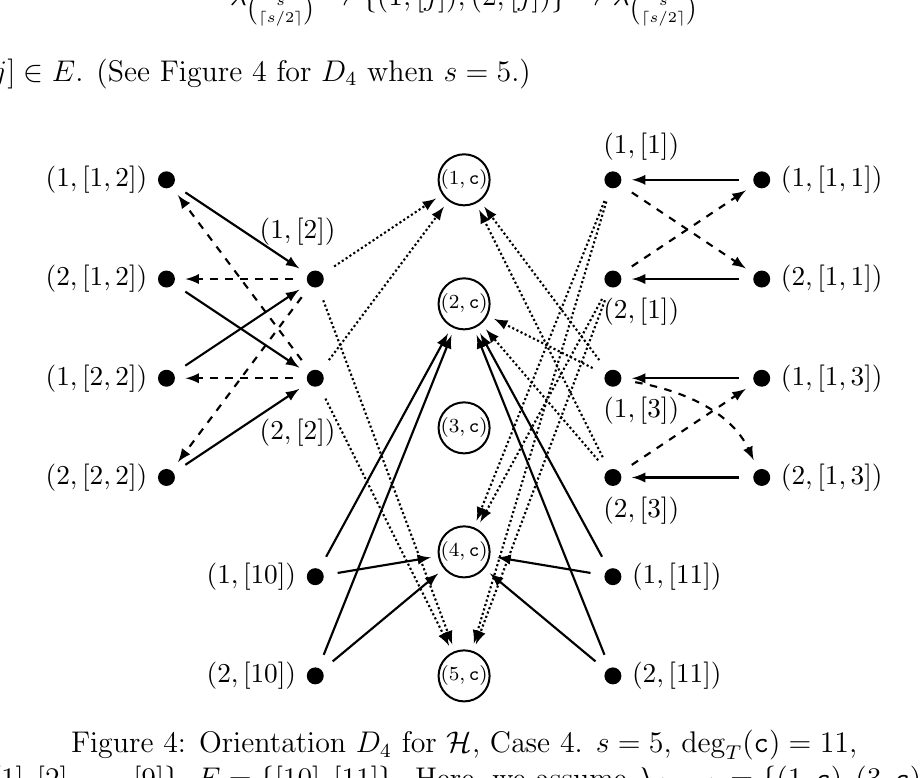
for H , Case 4. s = 5, deg 4